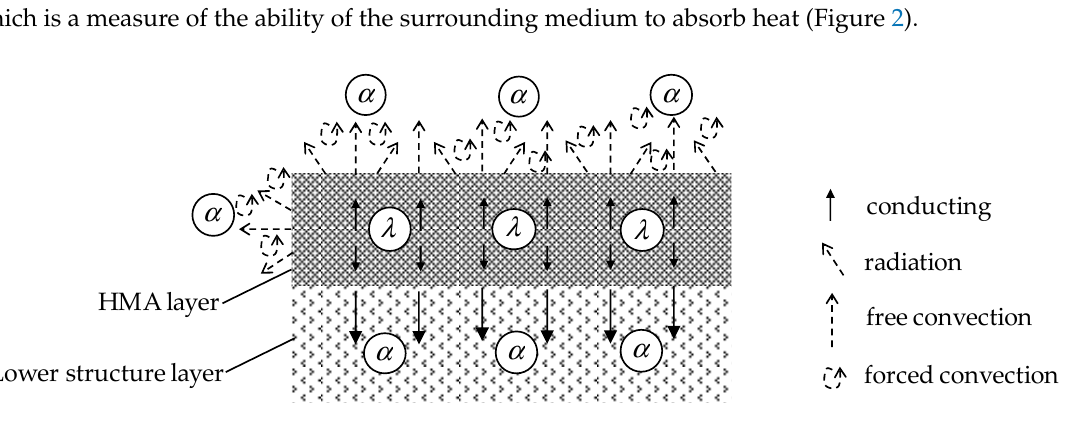
Figure 1. Example values of α for air (for free and forced convection) and for water (for forced